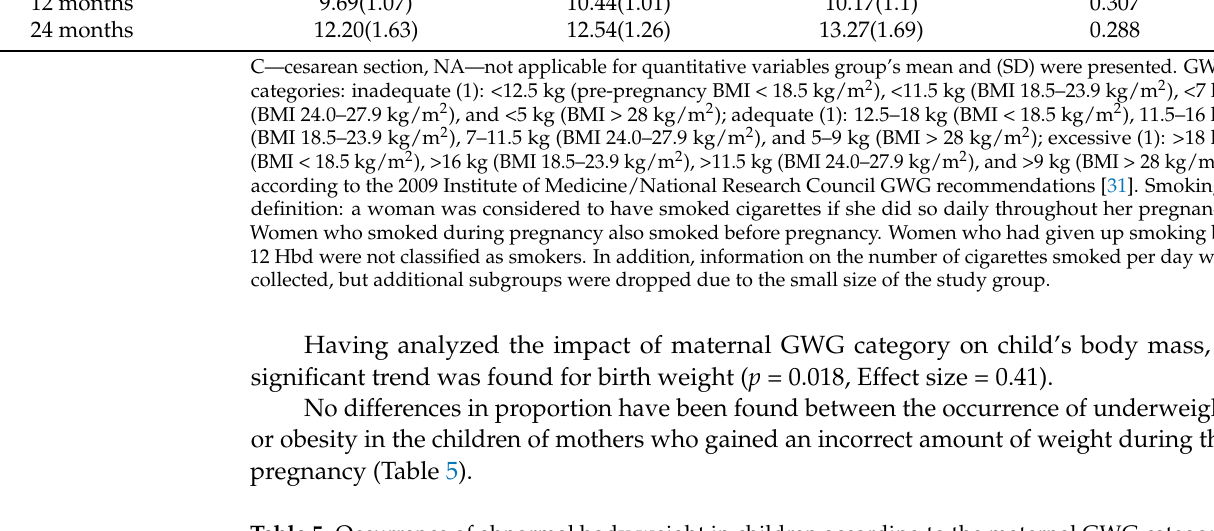
Table 5. Occurrence of abnormal body weight in children according to the maternal GWG